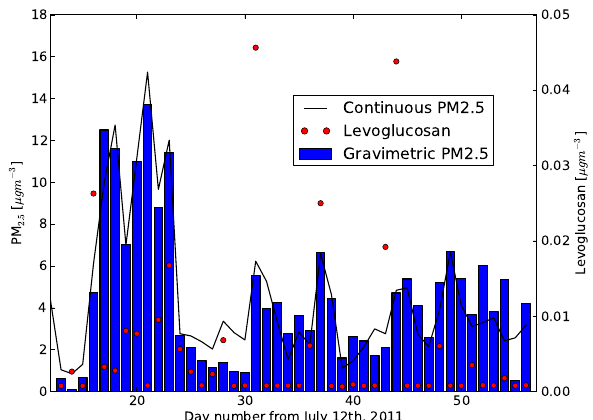
Fig. 13. Time series of 24h average gravimetric and continuous PM 2 . 5 (µgm − 3 ) and 24h filter-based levoglucosan samples (µg m − 3 ) from 12 July–25 August 2011, encompassing the BORTAS-B measurement